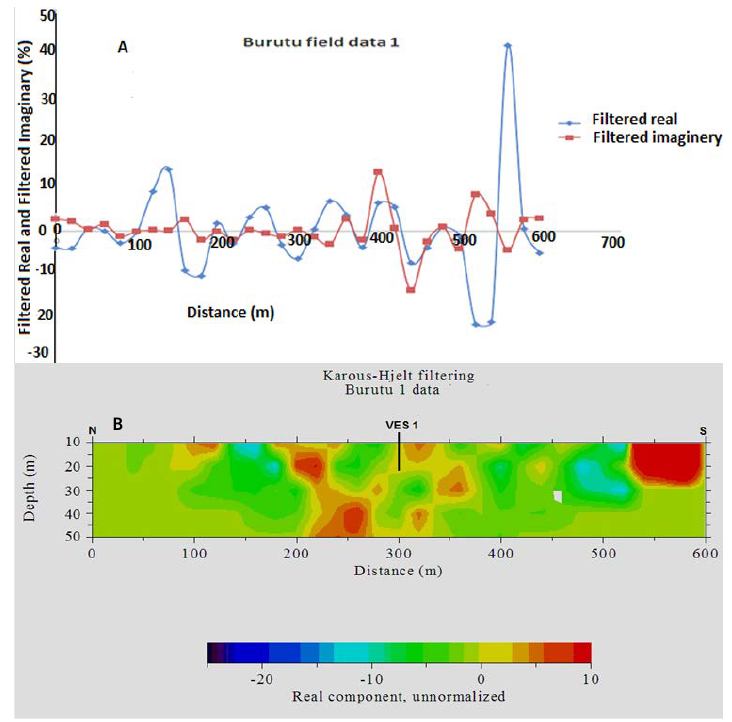
Figure 2. Plot of filtered Real and Imaginary components ( A ) and current density pseudo-section ( B ) for VLF Profile 1.